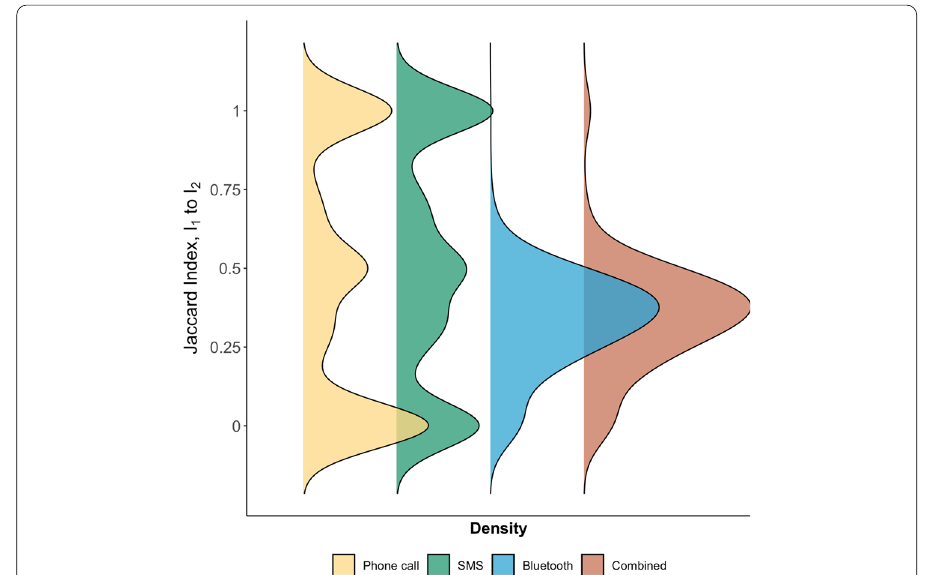
Fig. 3 The Jaccard Indexes are averaged over the participants for two consecutive intervals. The high turnover rates in the person-to-person network and the combined network are reflected as the larger Jaccard Indexes between the two intervals in the two